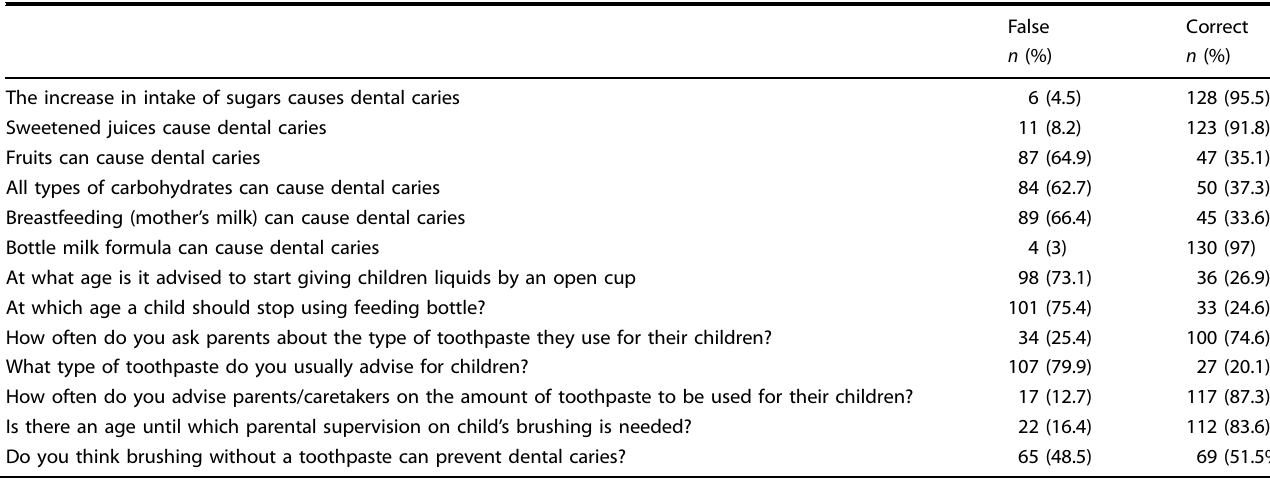
Table 3. Percentages of correct and false responses on questions of different